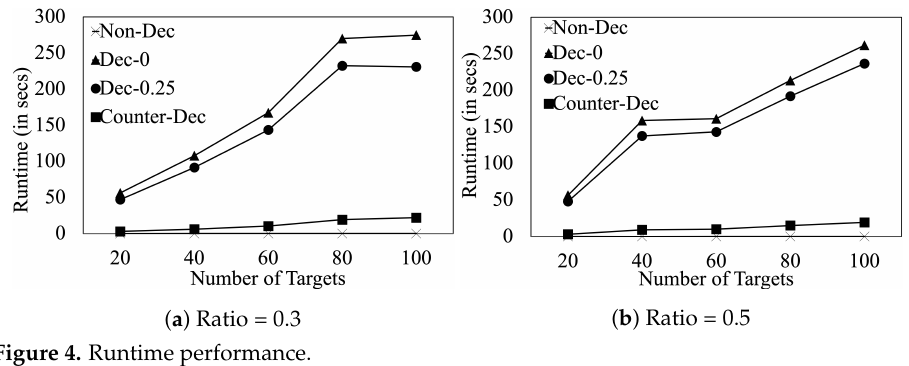
Figure 4. Runtime performance.